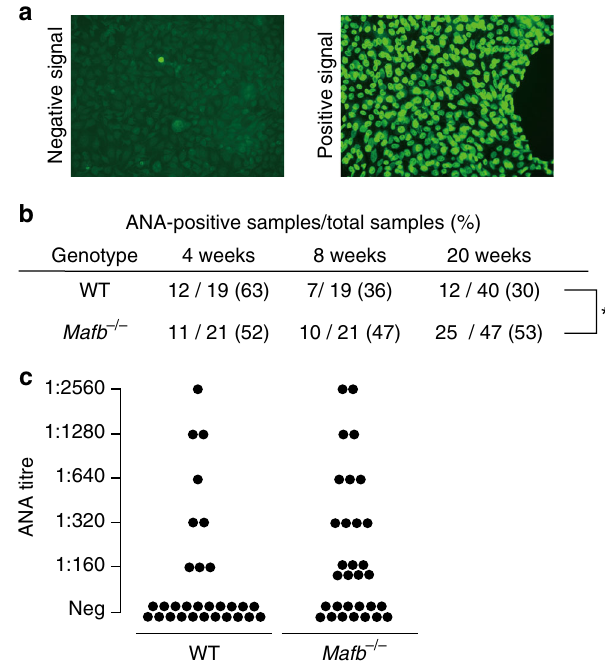
Fig. 5 ANAs are detected in serum from fetal liver transplanted Mafb − / − mice. a Nuclei of HEp-2 cells were stained with mouse serum from WT or Mafb − / − fetal liver-transplanted mice using the HEPANA test. A positive signal indicates the presence of ANA. b Table showing ANA-positive numbers using serum diluted 1:60 and collected 4, 8, and 20 weeks after fetal liver transplantation; 4 – 8 weeks (male: WT, n = 19; Mafb − / − , n = 21), 20 weeks (female: WT, n = 12; Mafb − / − , n = 15; male: WT, n = 28; Mafb − / − , n = 32). * p < 0.05 (Fisher ’ s exact test). c Serum collected from WT or Mafb − / − mice 20 weeks after transplantation was diluted 160-fold, 320-fold, 640-fold, 1280-fold, and 2560-fold (WT, n = 30 (male, n = 19; female, n =